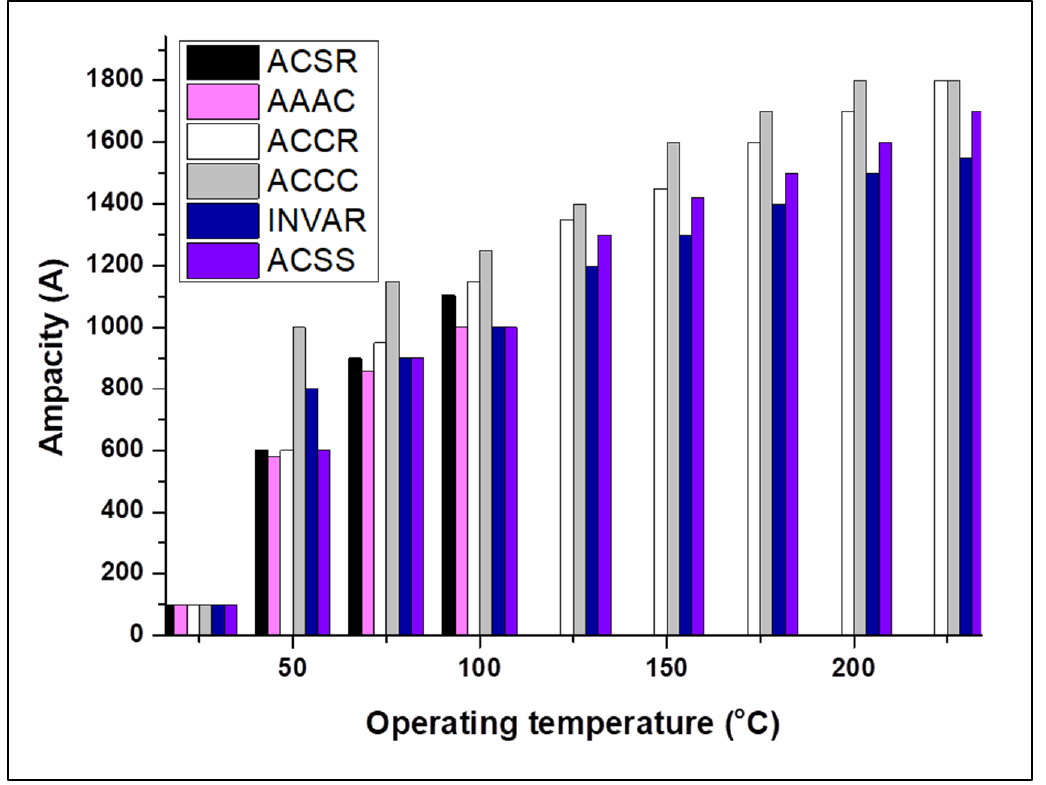
Figure 4. Ampacity versus operating temperature of transmission conductors [39].